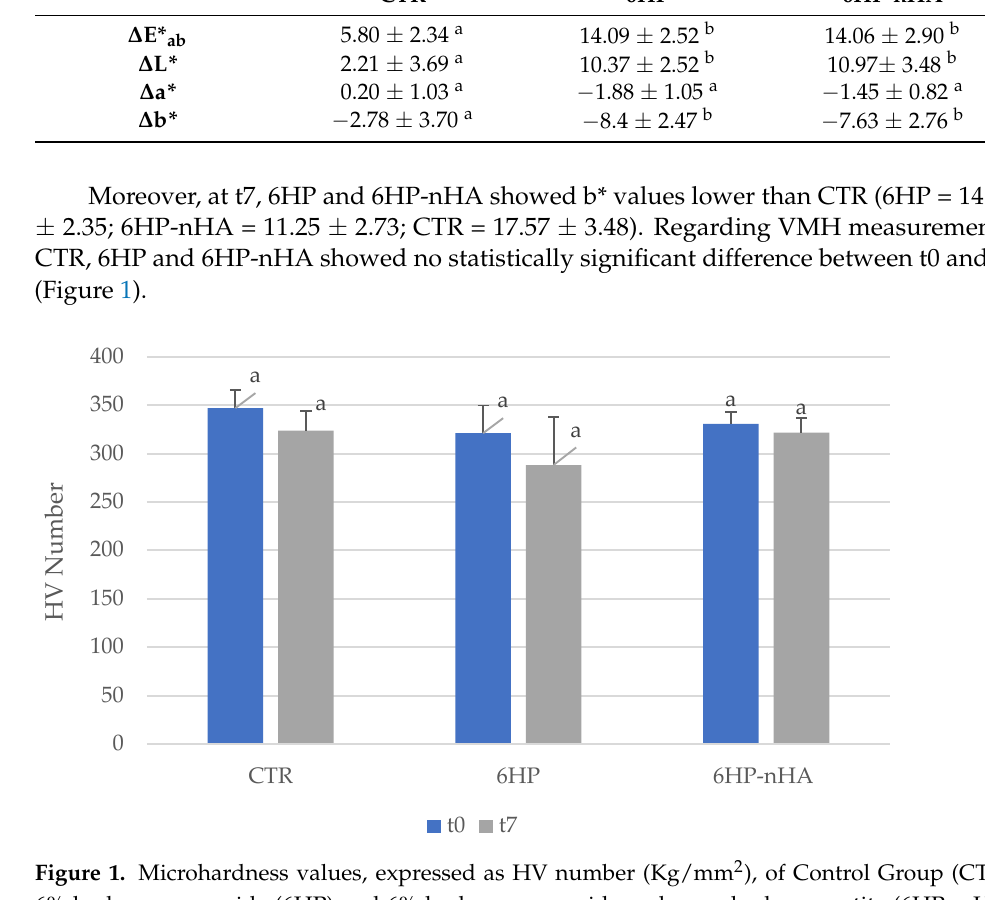
Table 3. Average and standard deviation of color differences ( ∆ E* ab ) and single parameter differences ( ∆ L*, ∆ a*, ∆ b*) between the baseline and after 7 days of Control Group (CTR), 6% hydrogen peroxide (6HP) and 6% hydrogen peroxide and nano-hydroxyapatite (6HP- nHA). Different superscript letters indicate statistical significance between groups. One-way ANOVA—Tukey’s multiple comparison test, p < 0.05.